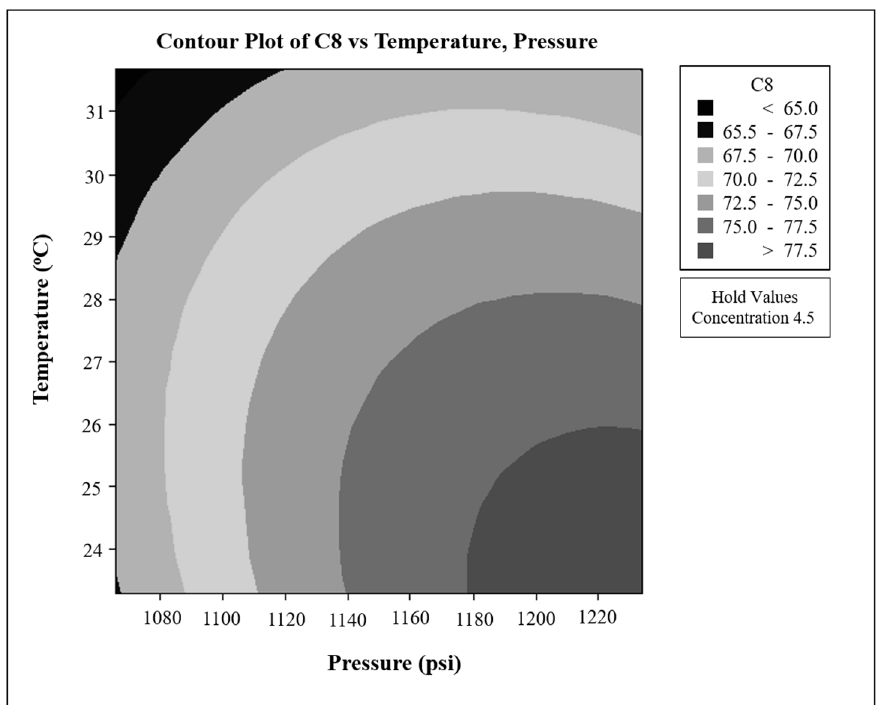
Figure 5. Cyclic trimer concentration dependence at various temperatures and pressures for a PBT concentration in HFIP of 4.5 wt